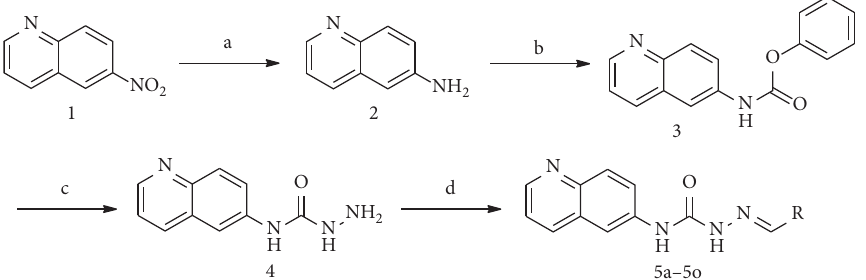
Scheme 1: Synthesis of target compounds 5a–5o . (a) Pt/C, H 2 , MeOH; (b) phenyl chloroformate, triethylamine, DCM; (c) 80% hydrazine hydrate, 95% ethanol; (d) aldehydes,